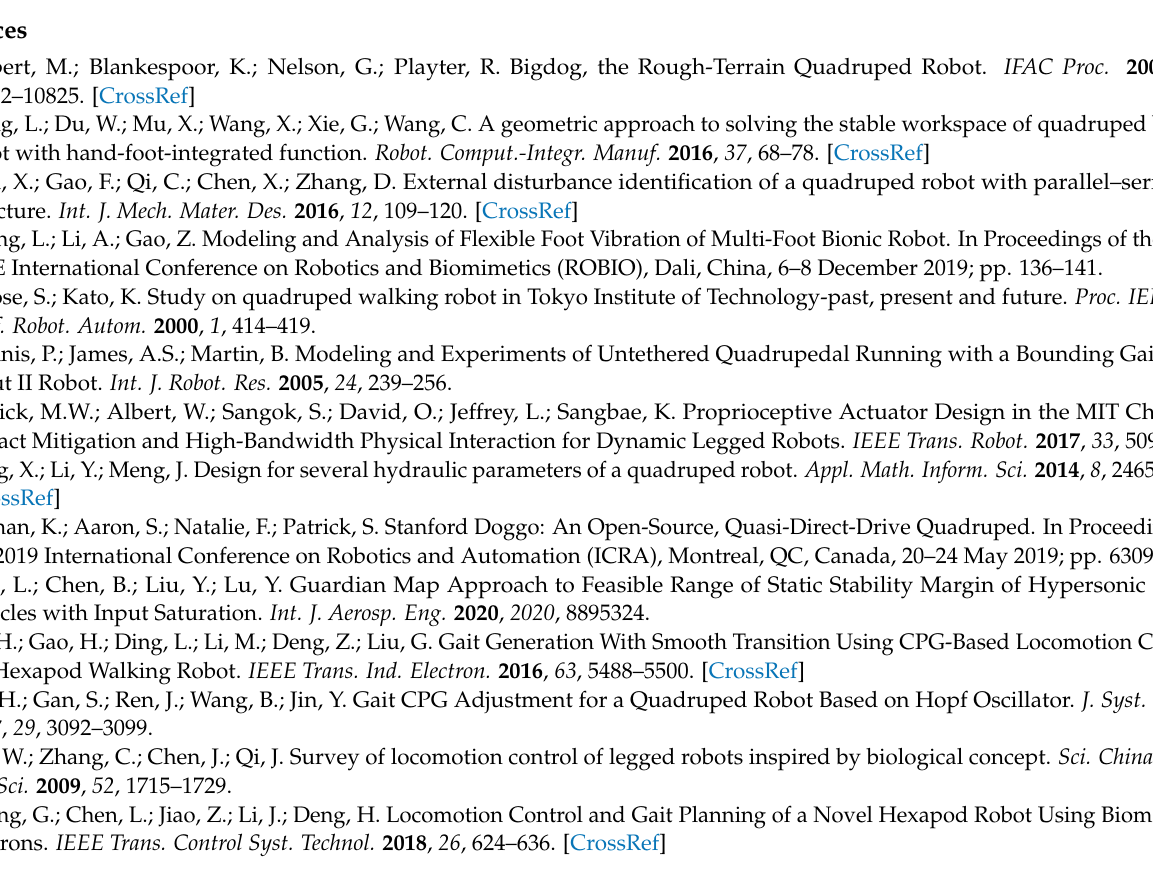
precision and more stable control effect compared with the cascade PID